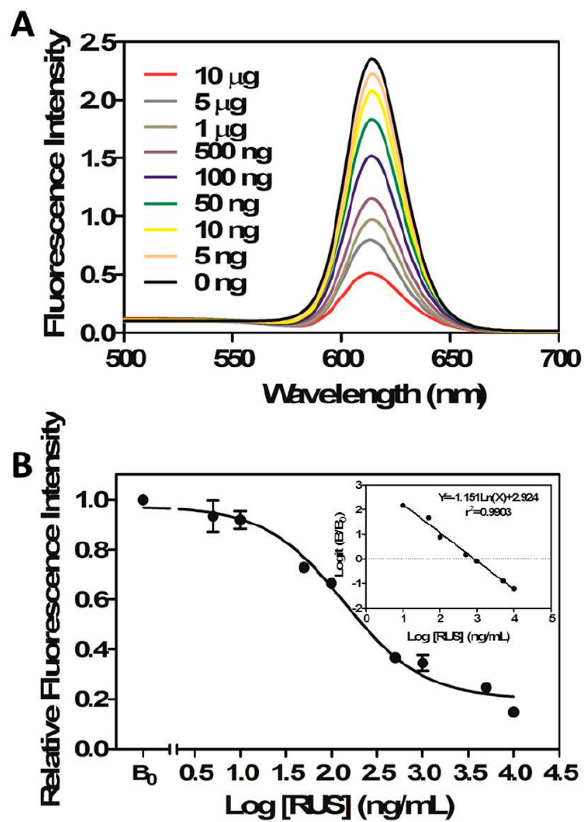
Figure 3. Fluorescence spectra of the FLISA based on QD-mAbs in the presence of various concentrations of RUS (0–10 μ g/mL) under optimal experimental conditions ( A ); Standard curve for RUS ( B ). Each point represents the mean ± SD from three determinations in FLISA (excitation wavelength: 400 nm, emission wavelength: 620 nm).